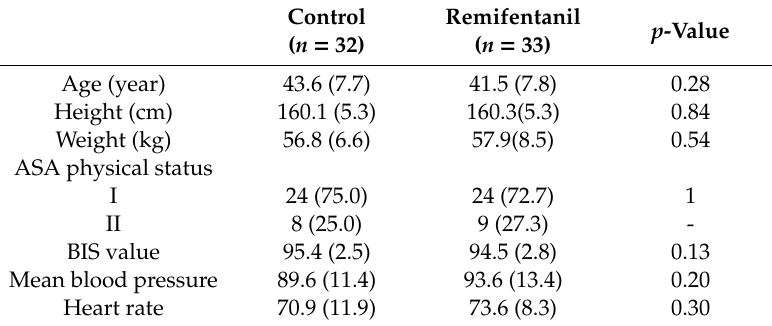
Table 1. Demographics and Baseline Hemodynamics of the Study Patients.